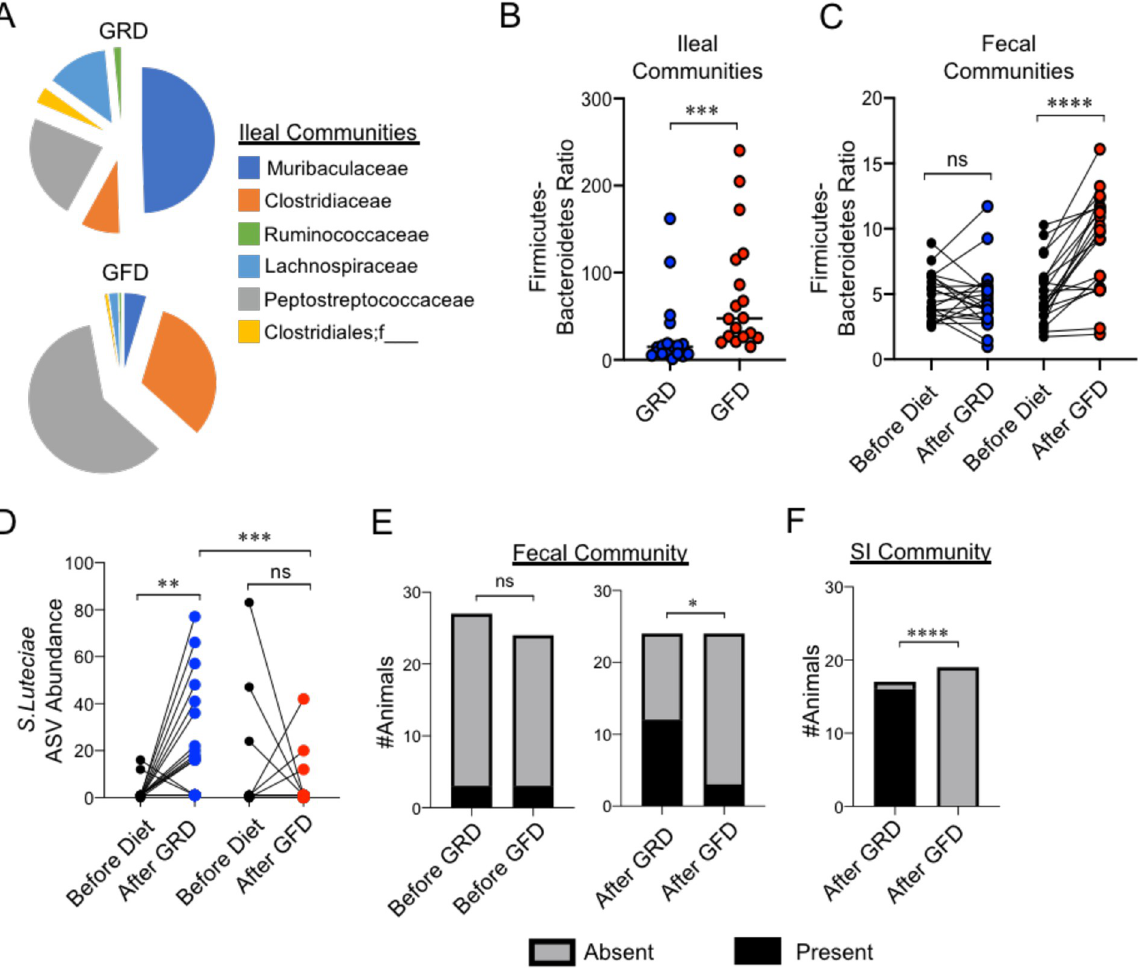
Fig 4. GFD exposure limits pathobiont colonization of the SI. (A) Pie charts depict the shifts in relative abundance of bacterial families whose abundance were significantly altered in the SI due to diet treatment. (B) SI community F-B ratios between GRD and GFD J H-/- cohorts are shown. Two-tailed unpaired Student’s t-test; ��� = p < 0.001. (C) Fecal community F-B ratios between GRD and GFD J H-/- cohorts are shown. Paired t-tests were used to compare how GRD or GFD exposure influenced fecal F-B ratios. A Mann-Whitney U test was used to compare how GRD and GFD exposure influenced SI F-B ratios. (D) S . lutetiensis ASV abundance in fecal communities before and after GRD or GFD exposure are shown. Paired t-tests were used to compare”before” vs. “after” groups, and an unpaired t-test was used to compare “after GRD” vs. “After GFD” groups. (E) Stacked bar-plots depicting the incidence of S . lutetiensis in fecal communities of GRD or GFD exposed mice are shown. Fisher’s exact test. (F) Stacked bar-plots depicting the incidence of S . lutetiensis in SI communities of GRD or GFD exposed mice are shown. Fisher’s exact